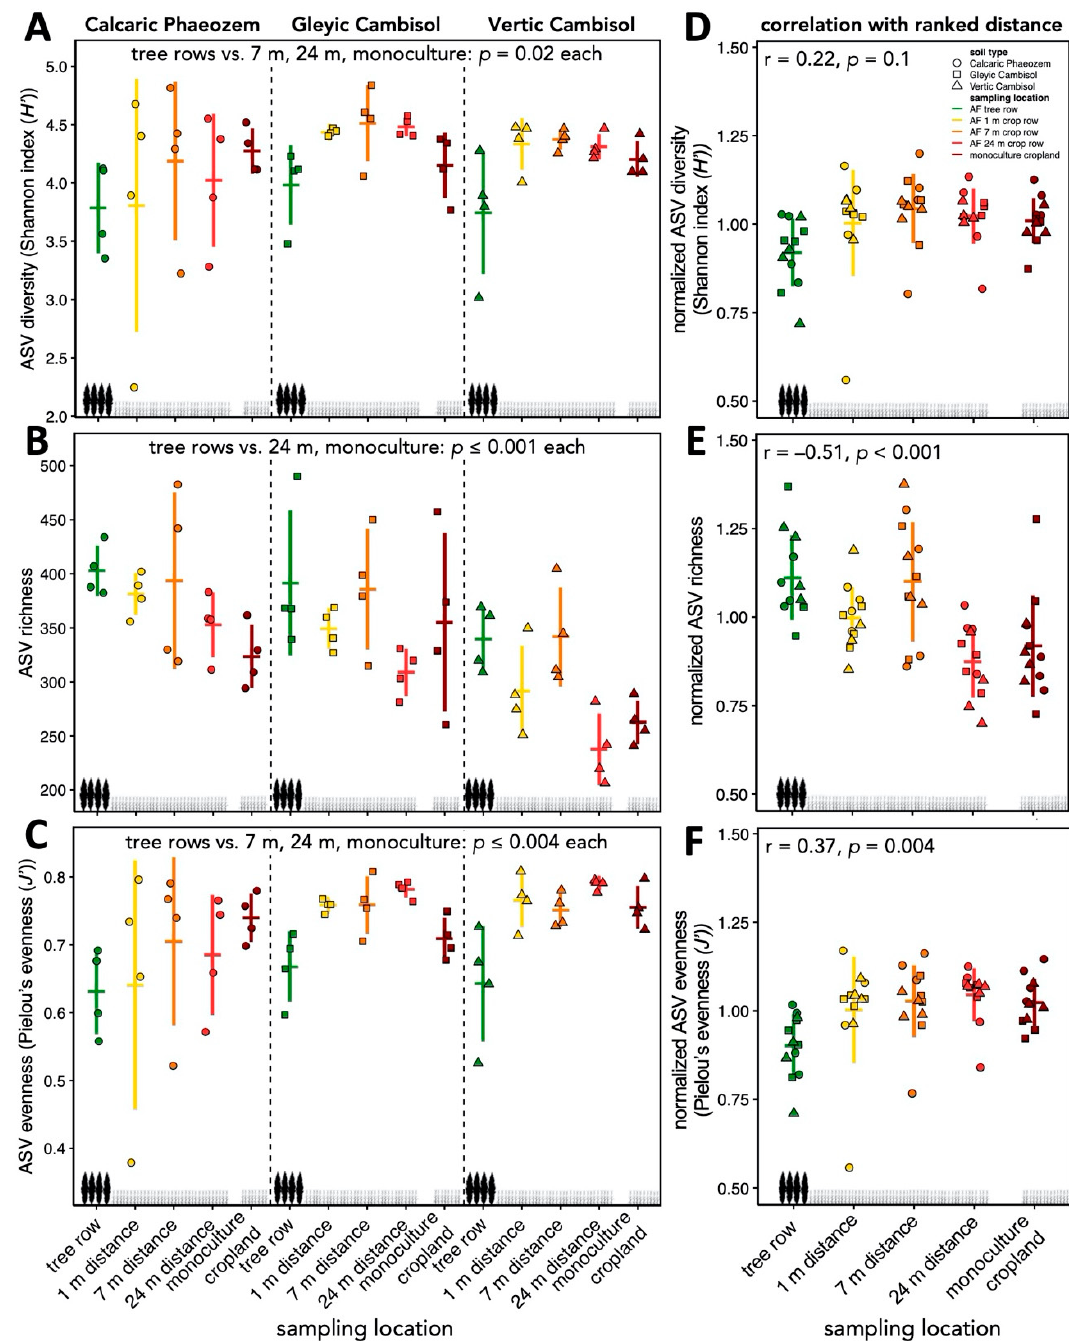
Figure 5. Alpha diversity of soil fungal communities and their correlation with distance from the tree rows. ( A – C ) Alpha diversity measures for fungal ASVs. Differences between sampling locations (tree row, 1 m, 7 m, and 24 m distance from the tree row within the crop row and monoculture cropland) were tested using linear mixed effect models with sampling location as fixed effect and site as random effect. Only differences between tree rows and arable land (1 m, 7 m, and 24 m distance from the tree row within the crop row and monoculture cropland) are reported in the panels. ( D – F ) Spearman rank correlations of alpha diversity measures with distances from the tree rows. Alpha diversity measures were normalized by the mean per site; distances from the tree rows were ranked (1 st rank: tree row, 2 nd rank: 1 m crop row, 3 rd rank: 7 m crop row, 4 th rank: 24 m crop row, 5 th rank: monoculture cropland) prior to correlation analysis. In all panels, circles, squares and triangles represent individual samples ( n = 4) from Calcaric Phaeozem, Gleyic Cambisol and Vertic Cambisol soil, respectively. Horizontal and vertical bars represent the mean and standard deviation, respectively. ASV = amplicon sequence